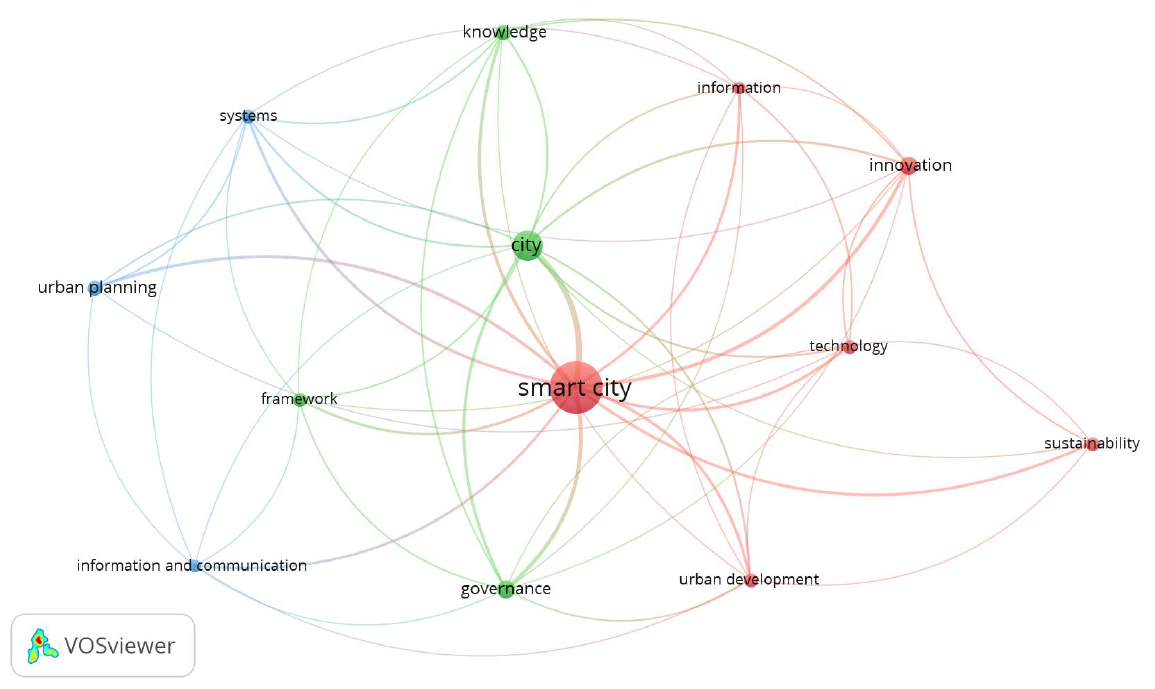
Figure 3. Network visualization Initial Period.